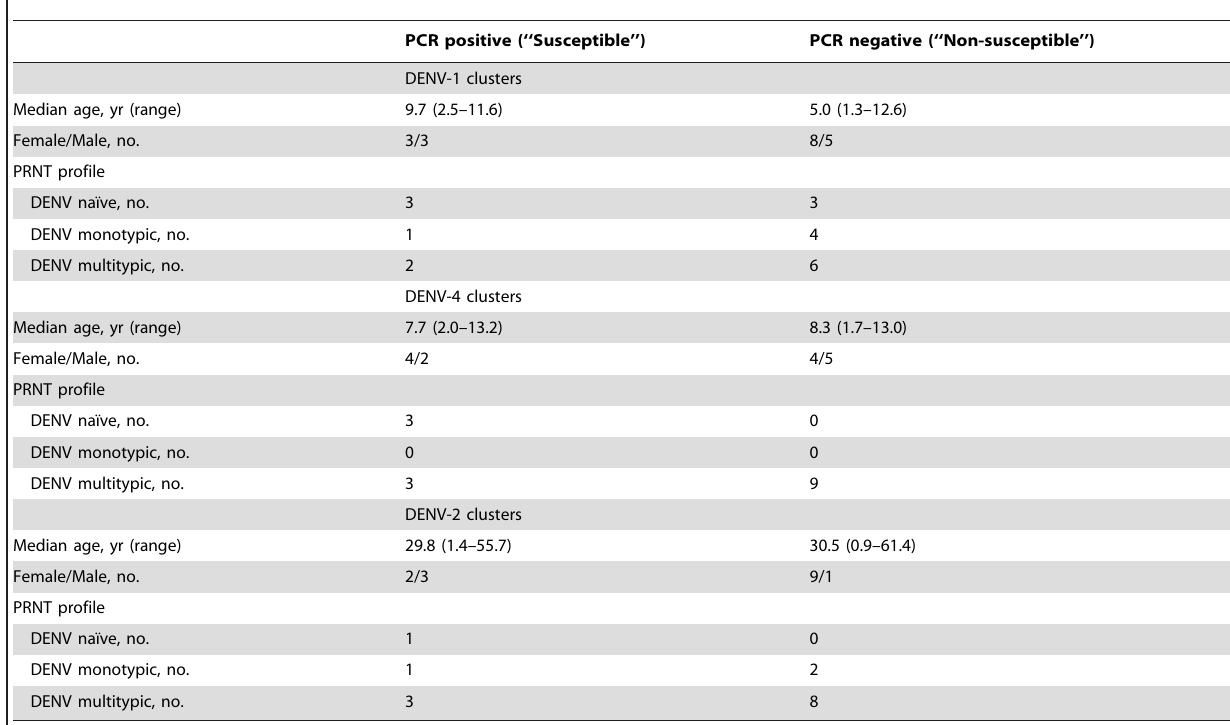
Table 1. Characteristics of dengue PCR positive (‘‘susceptible’’) and negative (‘‘non-susceptible’’)